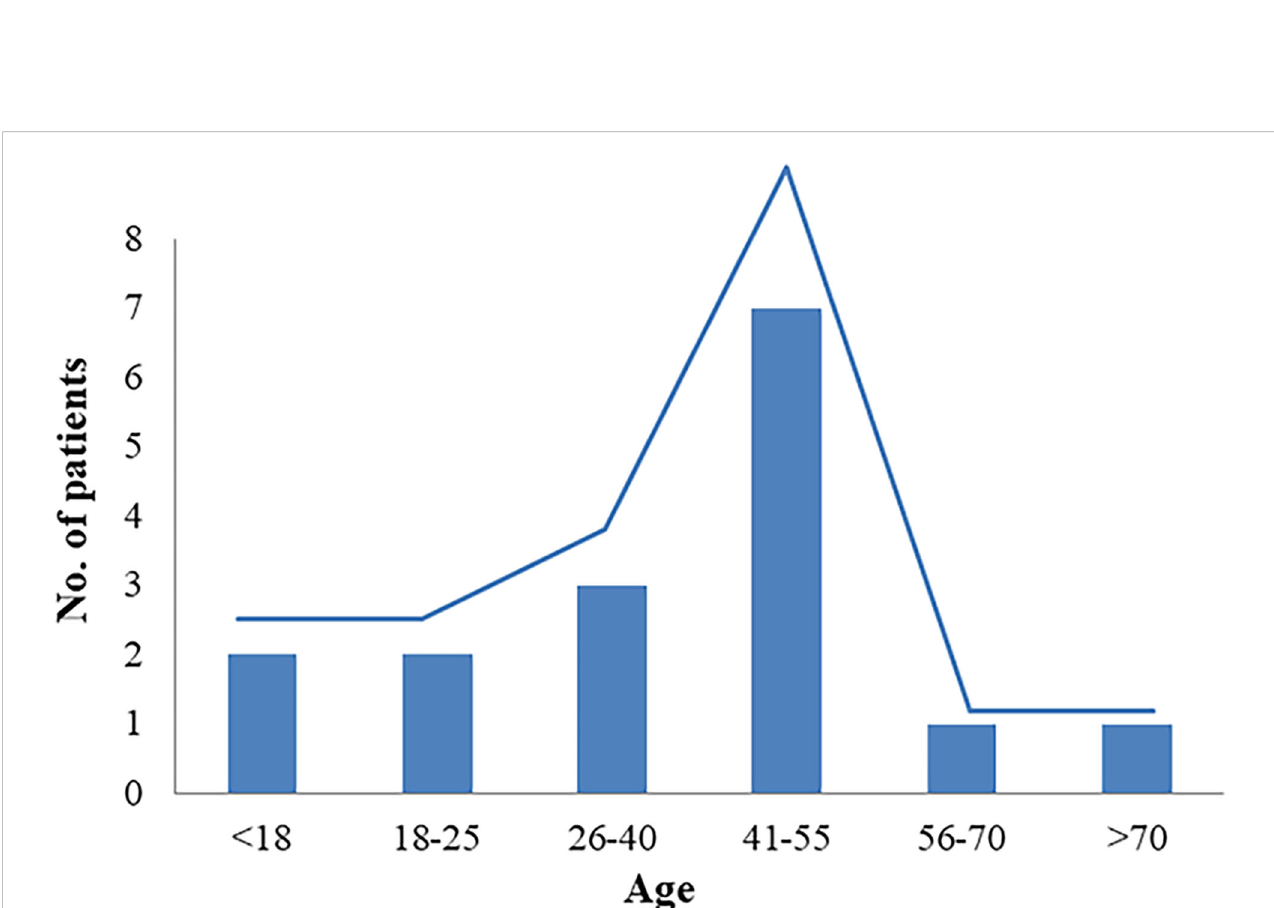
FIGURE 2 Patients ’ age distribution.